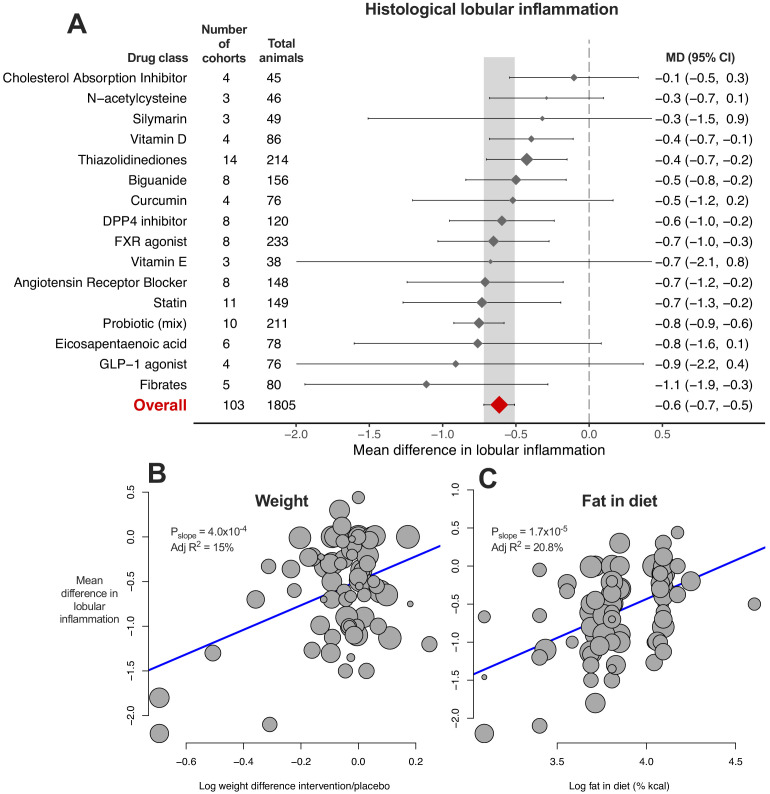
Meta-analysis of lobular inflammation in rodent studies of NAFLD.(A) Forest plot with subgrouping by class of drug. Individual studies have been hidden and only subgroup summaries are illustrated. The total number of animals is calculated from the sum of control and interventional animals for each subgroup. CI, confidence interval; DPP4, Dipeptidyl peptidase-4; FXR, Farnesoid X receptor; GLP-1, Glucagon-like peptide-1; MD, mean difference. (B) Meta-regression bubble plot using (log) difference in weight between interventional and control animals, after removal of studies using models that induce weight loss. (C) Meta-regression bubble plot using (log) fat (%kcal) in diet for each cohort.Figure 5—source data 1.Results of meta-analysis and meta-regression of lobular inflammation in rodent studies of NAFLD.Tab 1. Results from meta-analysis of lobular inflammation with subgroup by drug class. Tab 2. Results from meta-analysis of lobular inflammation with subgroup by individual drug. Tab 3. Results from meta-analysis of lobular inflammation with subgroup by drug class, after removal of outlier studies. Tab 4. Results from univariable meta-regression analyses. Tab 5. Results from multivariable meta-regression analyses.